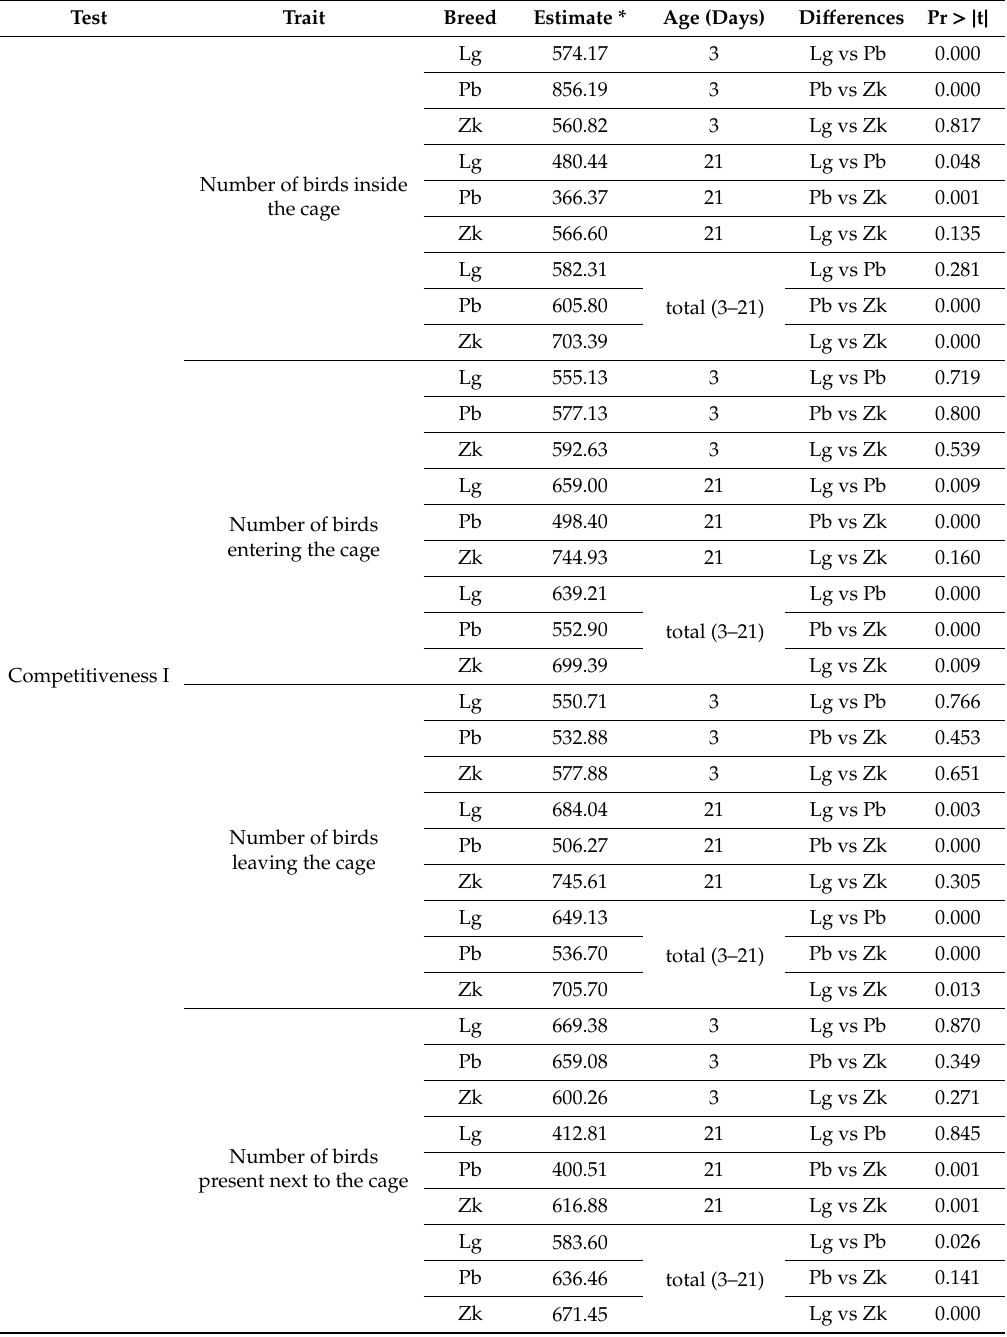
Table 2. Mean level of analysed indicators * and significance of di ff erences between the means in the Competitiveness I test in relation to the breed and age of